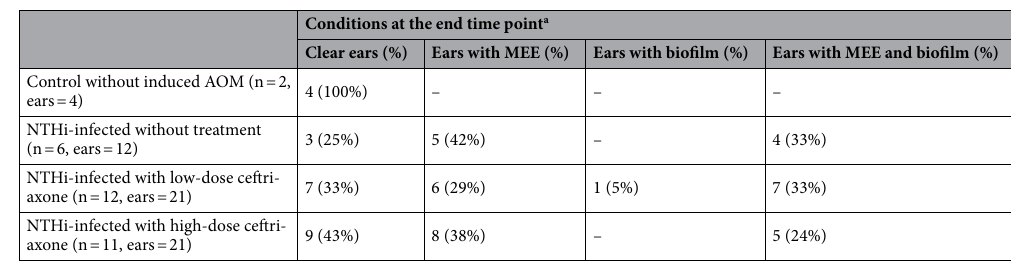
Table 2. Summary of antibiotic treatment response. a The ears with a complete blockage of the ear canal at the end time point were excluded for this